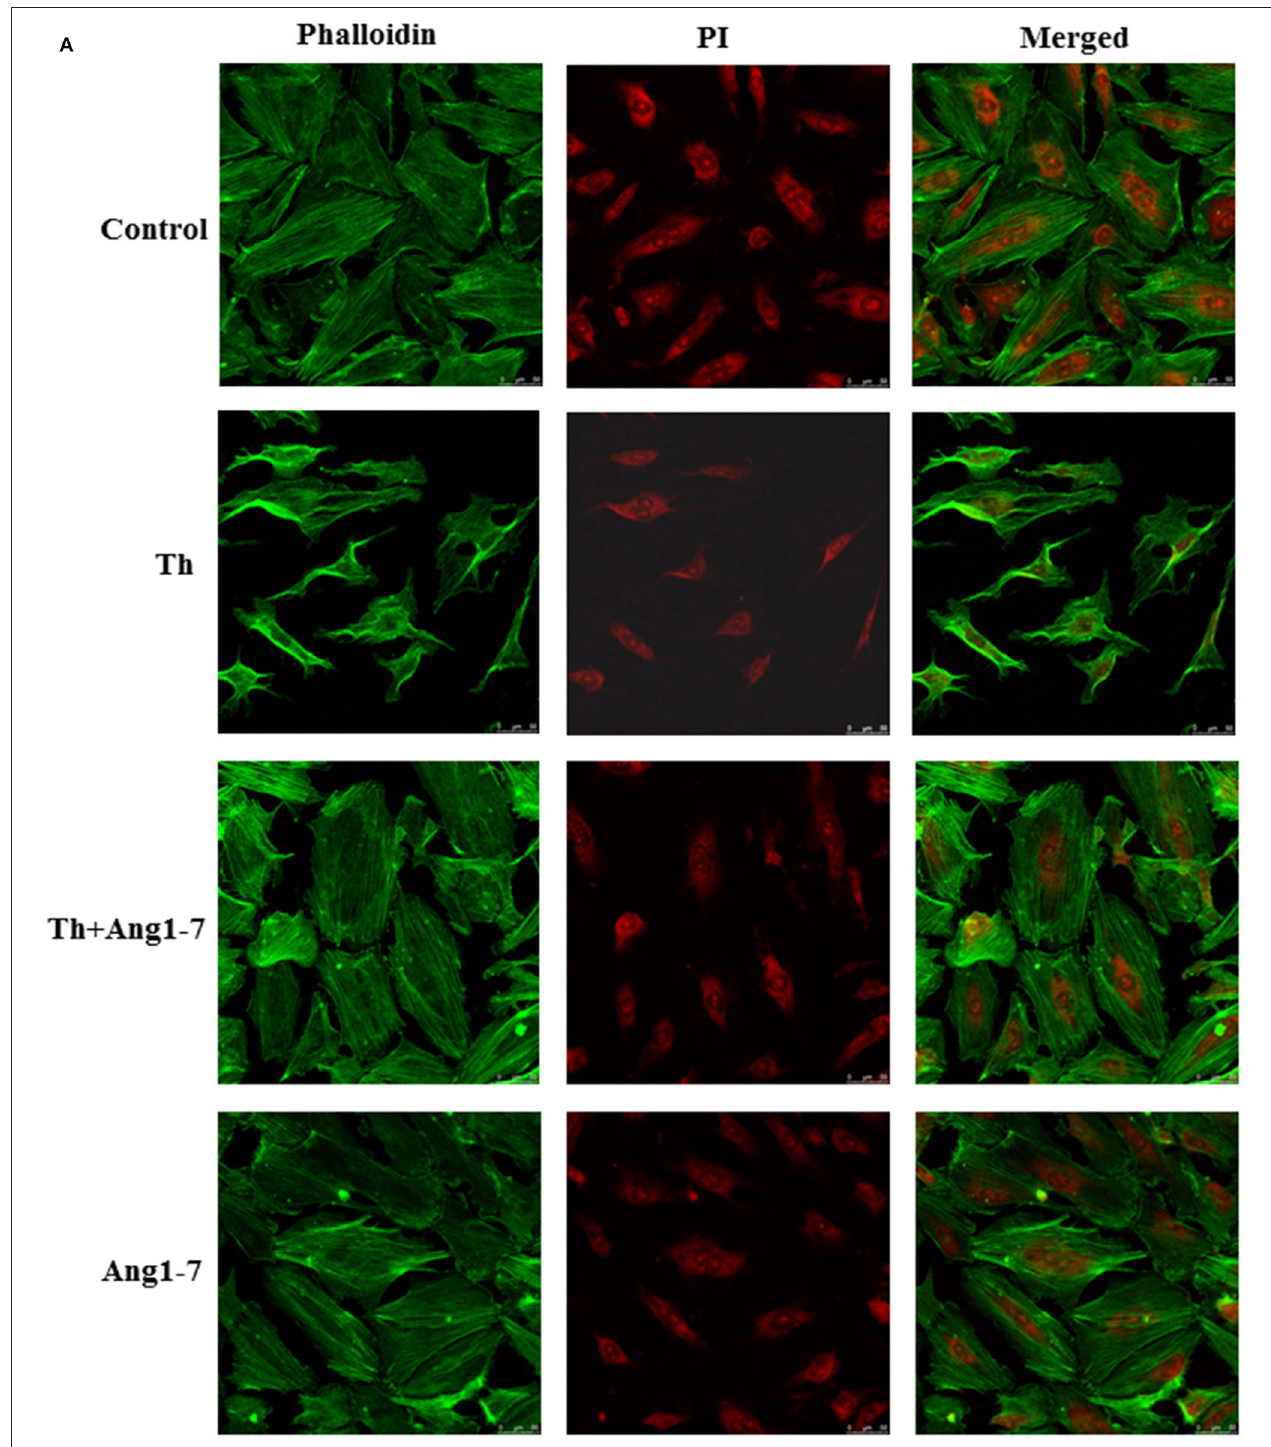
FIGURE 1 | Angiotensin-(1-7) prevents thrombin-induced phenotypic changes. (A) HAECs were stimulated with thrombin (2 U/mL) for 5h with or without 100nM angiotensin-(1-7) pretreatment 1h before the thrombin stimulation. Confocal microscopy revealed the spreading and polygonal morphology of untreated and angiotensin-(1-7)-treated HAECs. Thrombin treatment induced actin cytoskeleton derangement with variable cell retraction and increased cortical ring formation. On the other hand, thrombin-induced cytoskeleton abnormalities were prevented in HAECs pretreated with angiotensin-(1-7). Images represent results